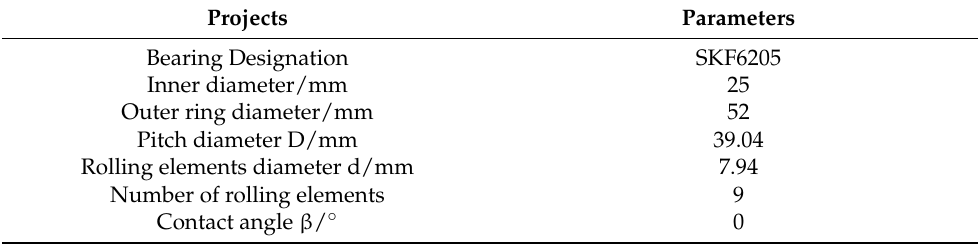
Figure 14. CWRU bearing test bench and its schematic diagram. Table 3. Detailed parameters of the SKF6205-2RS-type rolling bearing.